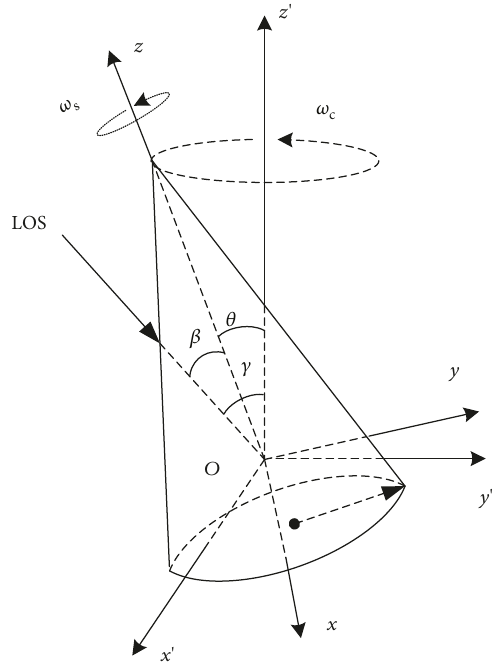
Figure 2: Geometry of the precession cone